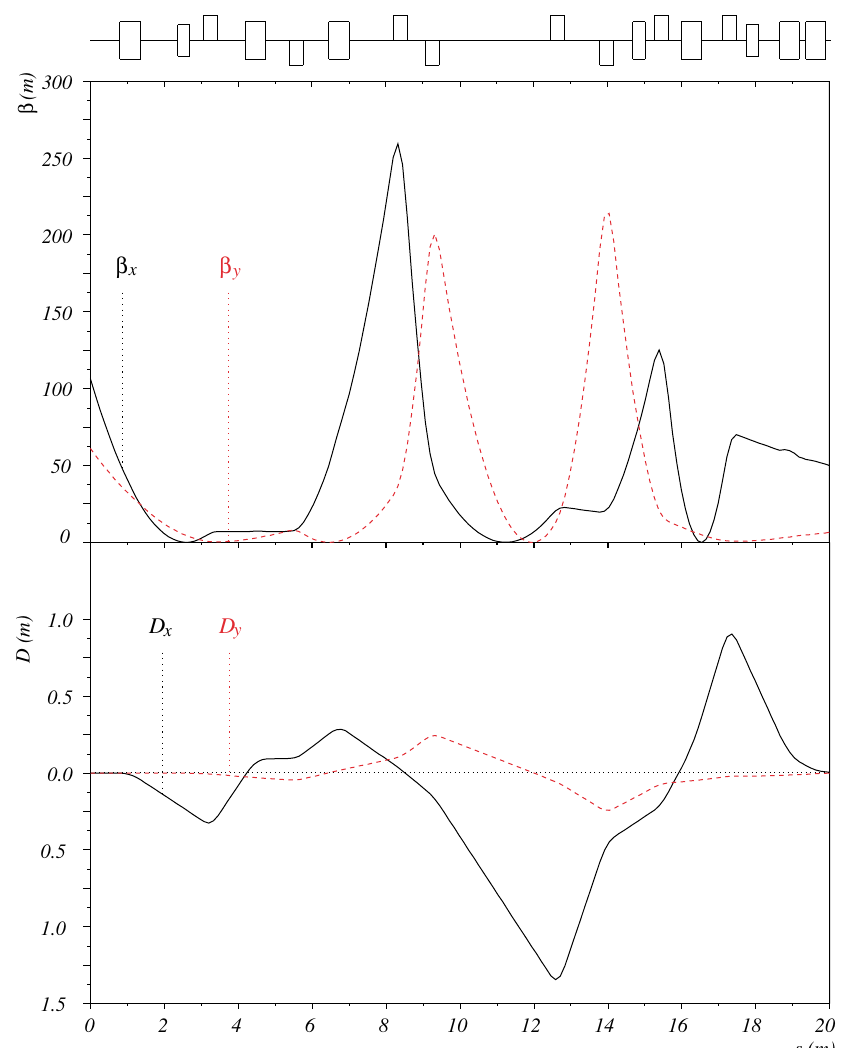
FIG. 7. (Color) Design optics of the injection line. The horizontal (solid line) and vertical (dashed line) (cid:5) functions are shown on the top graph, design dispersion functions for the horizontal (solid line) and vertical (dashed line) plane on the